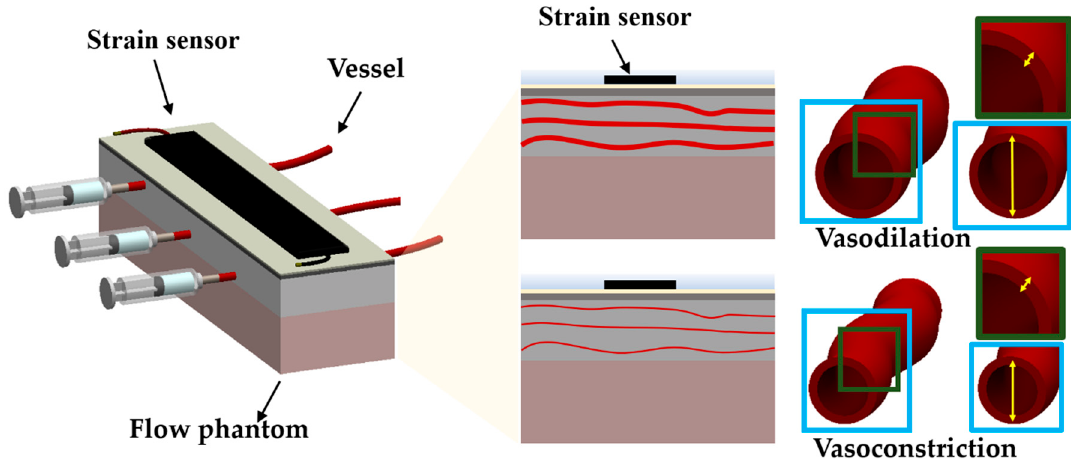
Figure 1. Conceptual illustration of measuring vessel diameter changes using the epidermal strain sensor. Blue boxes in the picture represent cross sections of vessels. Green boxes represent one quarter of the cross sections of the vessels. Yellow arrows in the blue boxes represent the diameters of the vessels. White arrows in the green boxes indicate the thickness of the vessels. P out